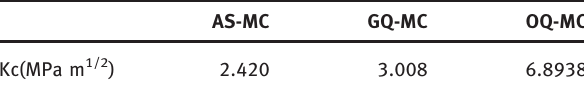
Table 2: Fracture toughness.